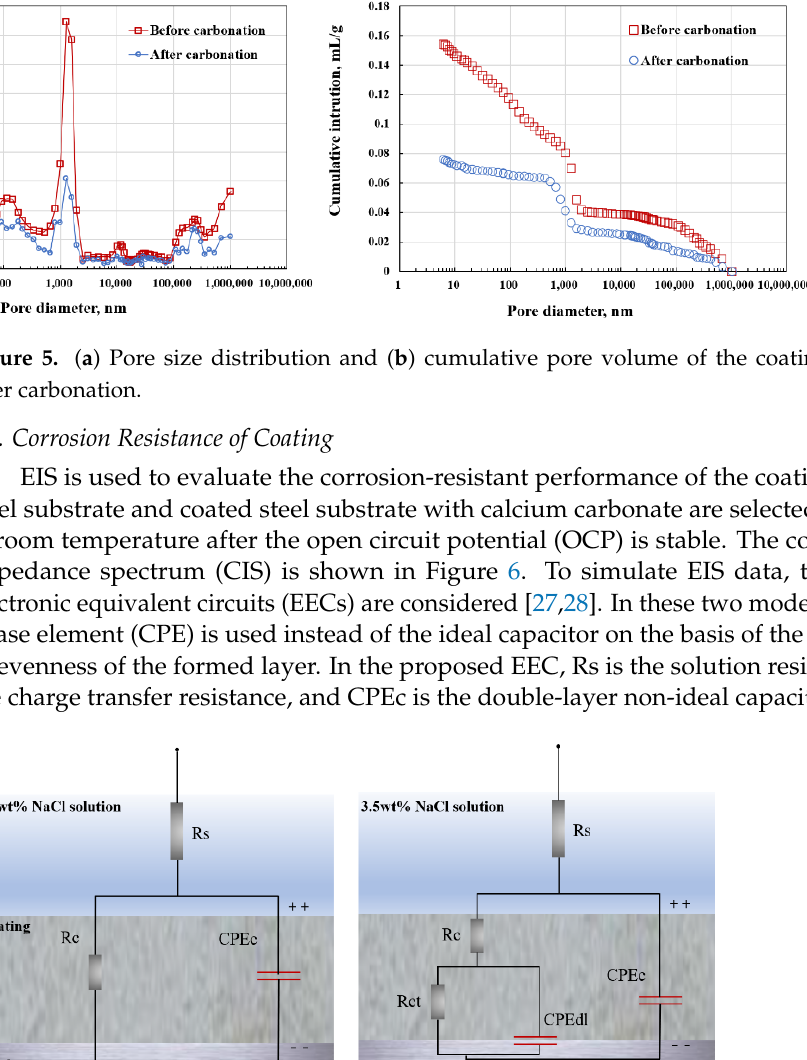
Figure 6. Equivalent circuits for modeling experimental impedance data.